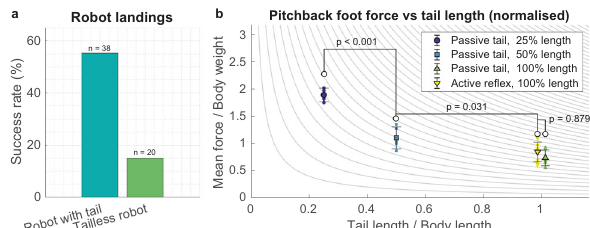
Fig. 7 Robotic model data testing the role of tails in landing. a Landing success of the robotic model showed that tails substantially increased landing performance compared to tailless condition. b Plot of mean foot adhesive force during pitch-back for three different tested tail lengths (the mean of the force data plotted in Fig. 6a – d), and with an active tail re fl ex included. Isolines of force proportional to tail length − 1 are plotted in the background for comparison with the relationship indicated by the theoretical model. Lines connecting bars indicate P values from ANOVA comparisons. The tail length datapoints for 100% tail length are offset ±1% to facilitate comparison between active and passive tails, though the true tail lengths are identical. Sample size, n = 4, 5, 7, and 5 for 25%, 50% and 100% passive and active tails,